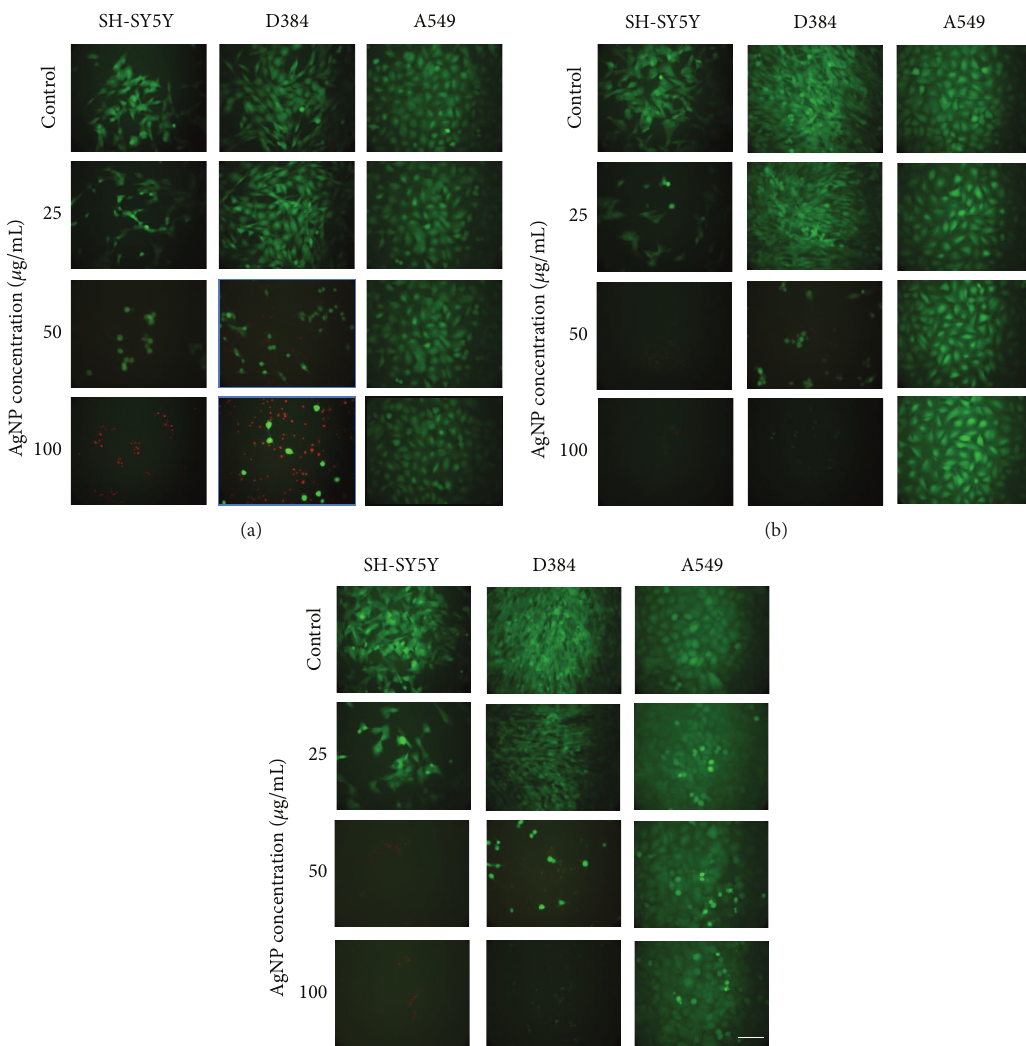
Figure 3: Membrane integrity evaluation. Representative images of randomly selected microscopic fields of cells (SH-SY5Y, D384, or A549) stained with calcein-AM/propidium iodide after 4 (a), 24 (b), and 48 (c) h exposure to increasing concentrations (25–100 𝜇 g/mL) of AgNPs. Green fluorescence patterns and the cellular morphology were similar to the controls. A strong decrease in cell viability for both cerebral cell lines was observed as evidenced by the presence of numerous red coloured cells (indicating damage to the cell membrane) at the highest doses (50–100 𝜇 g/mL). After 24 and 48 h, the cytotoxic effect of AgNPs was exacerbated. SH-SY5Y cells were the most sensitive towards AgNP since the cell loss was evident at the dose of 25 𝜇 g/mL, whereas pulmonary cells (A549) were less susceptible to AgNP exposure compared to cerebral cell types, showing a slight decrease of cell viability after 48 h exposure only (scale bar is 100 𝜇